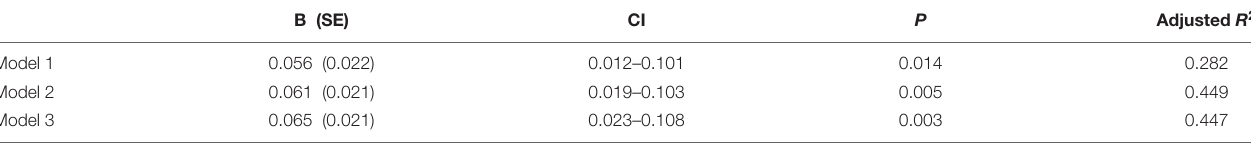
TABLE 2 | The results of multiple linear regression analyses assessing the associations between the serum copper level and MMSE in non-demented older